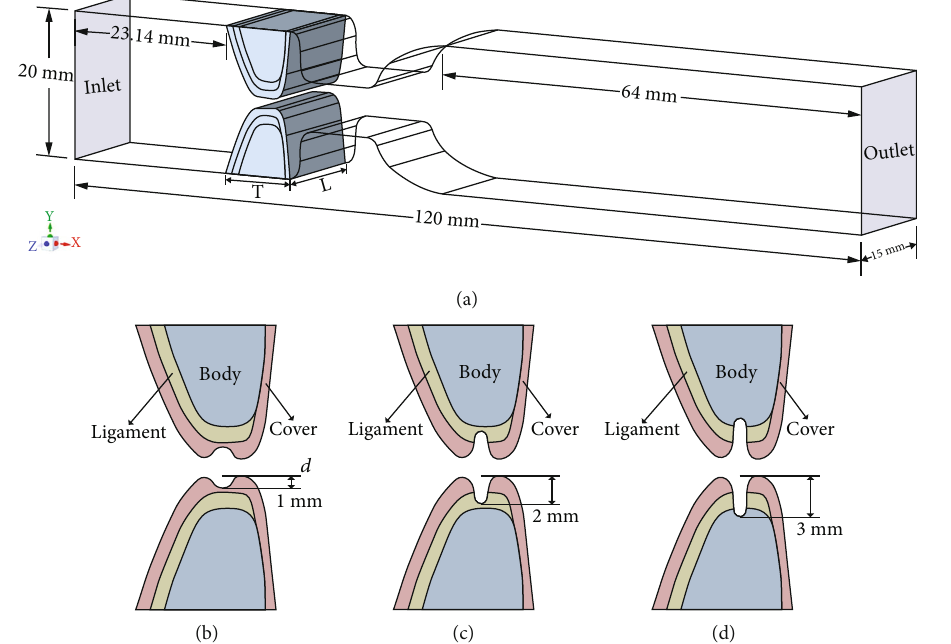
Figure 1: (a) The geometry of computational domain with true and false vocal folds. (b) Type I sulcus vocalis (with depth of 1mm). (c) Type II (2 mm). (d) Type III (3